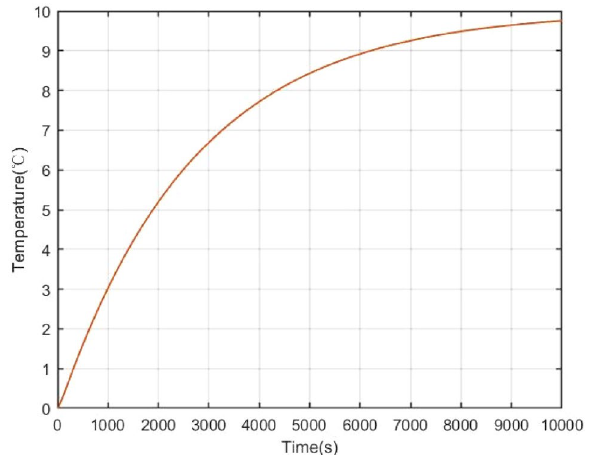
Figure 5. Core coolant temperature open-loop response under reactive perturbation.